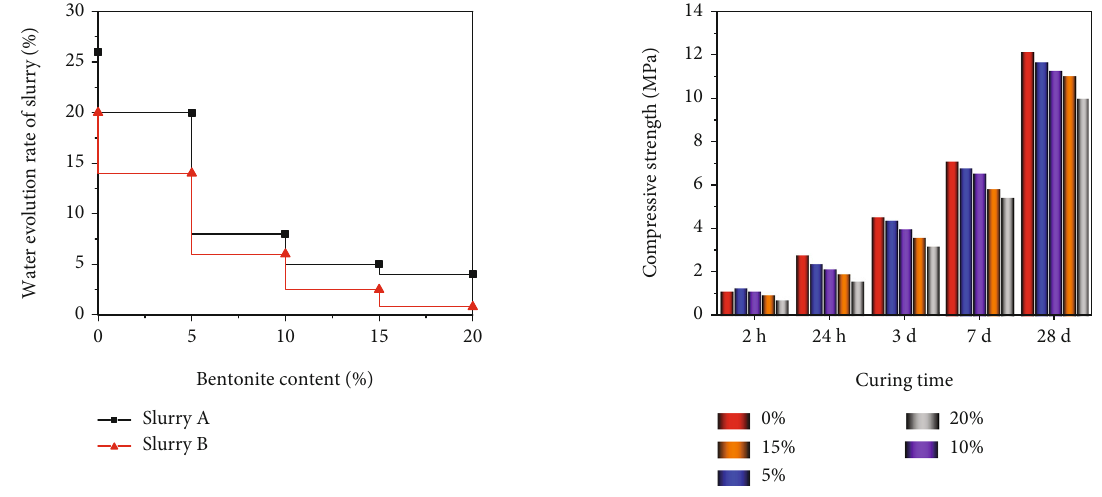
(b) Relationship between bentonite content and compressive strength of slurry Figure 3: In fl uence of bentonite on compressive strength of slurry. Table 1: Factor level table of orthogonal test.